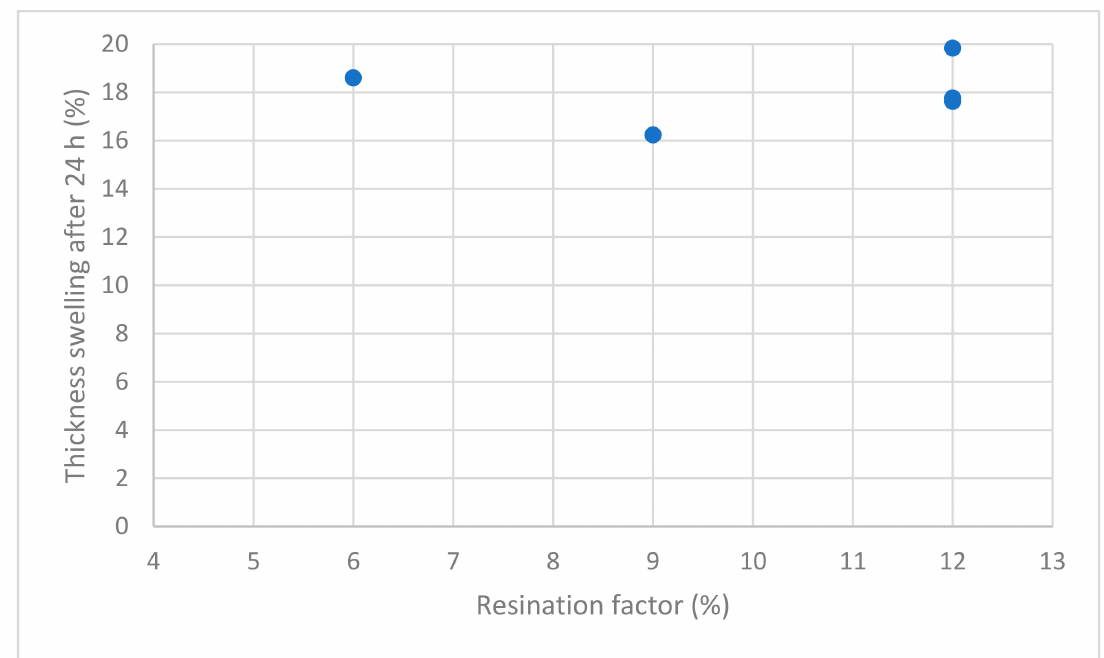
Figure 2. Correlation between thickness swelling (TS) after 24 h, and resination factor (6%, 9%, and 12% UF).